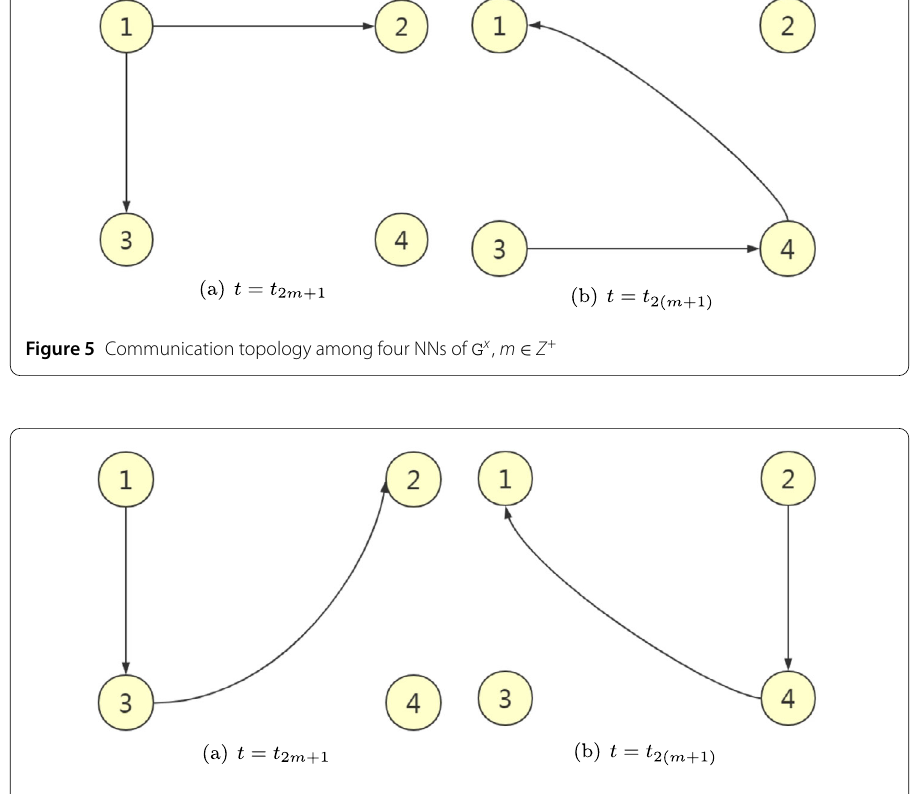
Figure 6 Communication topology among four NNs of G y , m ∈ Z